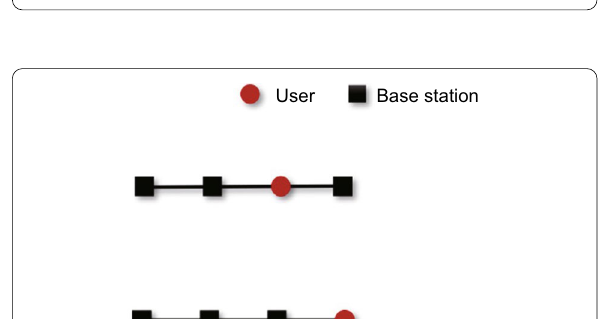
Fig. 3 Positioning principle